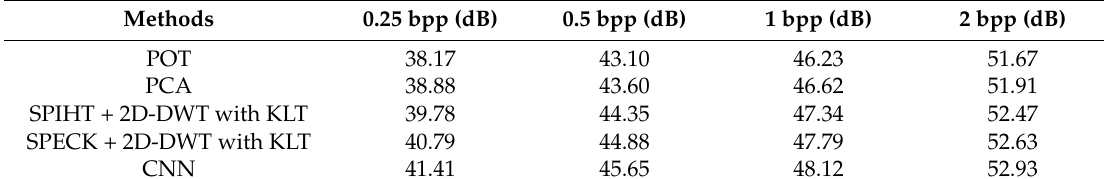
Table 4. Comparison of the compression performance with different compression method.